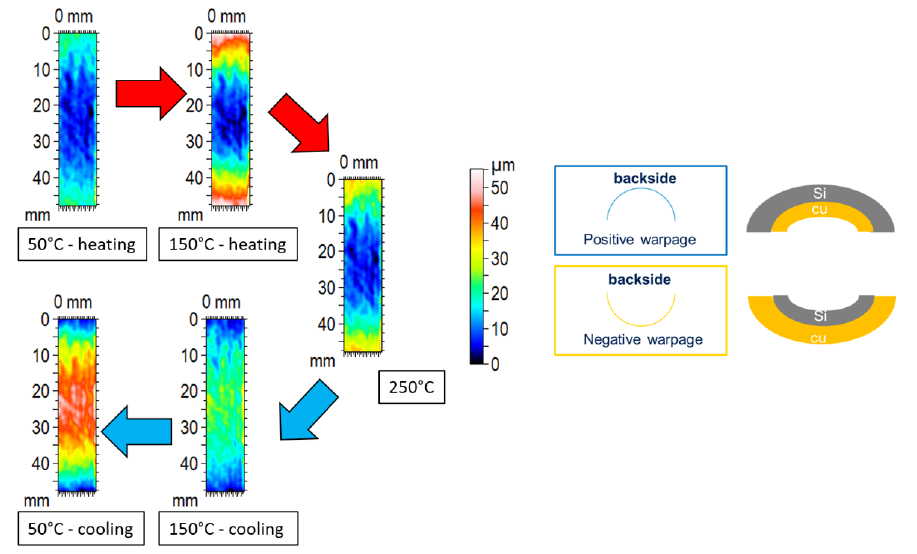
Figure 4. Warpage maps at different temperature for temperature profile “W/o plateau”. On the right, the considered sign convention in Figure 5 is shown.